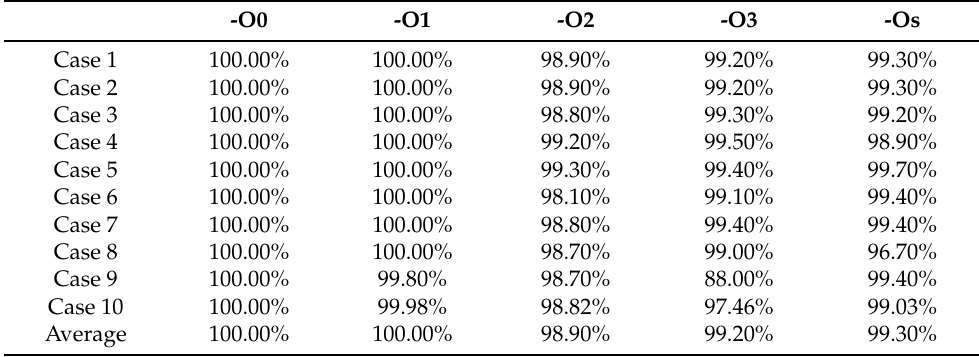
Table 5. Success rate of the single-trace attack for each optimization